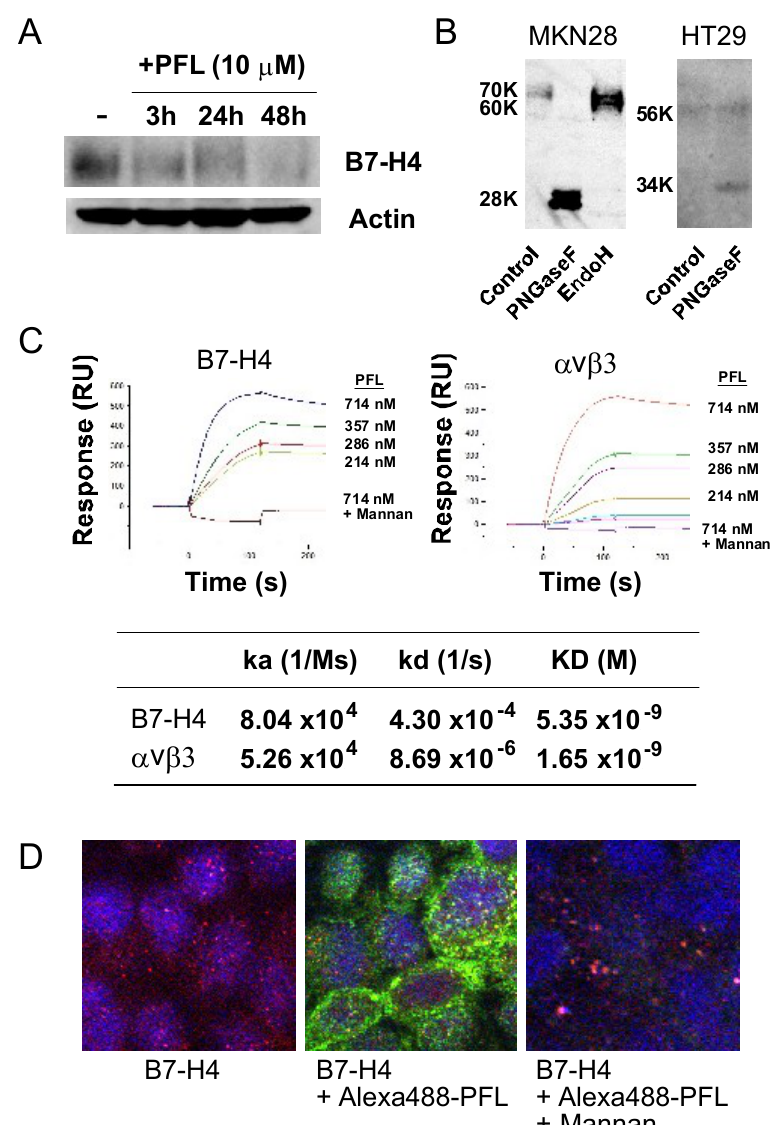
Figure 5. PFL decreases B7-H4 protein levels. ( A ) Decreased abundance of B7-H4 in MKN28 cells treated with PFL. MKN28 cells were incubated with 10 μM PFL in RPMI-1640 containing 10% FBS for 3, 24, and 48 h. The cells were lysed and subjected to western blot analysis. The figure shows results of one experiment that was replicated at least twice with similar results. ( B ) Removal of B7-H4 glycan by endoglycosidases. MKN28 and HT29 cell lysates were treated with PNGase F and Endo H, and subjected to western blot analysis. ( C ) Direct interaction between PFL and B7-H4 or αvβ3 was analyzed by surface plasmon resonance (SPR). Following immobilization of the ligand onto the CM5 sensor chip, the indicated concentrations of lectin solution were injected. Sensorgrams for binding were recorded in real time, and the response is expressed in resonance units (RU). Binding kinetics of the interaction between PFL and the ligand are shown. ka: association rate constant, kd: dissociation rate constant, KD: affinity constant. ( D ) Distribution of Alexa-488 PFL (green) and B7-H4 (red). Cellular localizations of Alexa-488 PFL and B7-H4 were examined with confocal fluorescence microscopy. Co-localization is shown as a yellow signal (Merge). Nuclei within the cells were stained with DAPI. The effect of yeast mannan (YM) (50 μg/mL) on PFL-B7-H4 interaction is also shown (right panel).